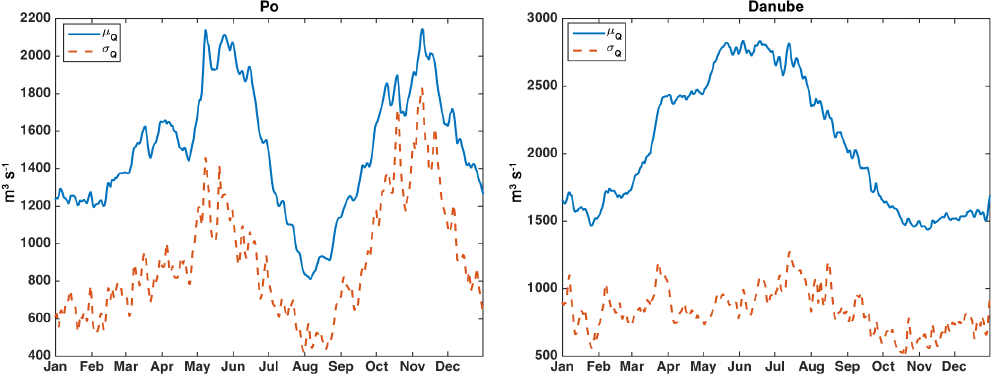
Figure 2. Daily mean value µ Q (m 3 s − 1 ) and daily standard deviation σ Q (m 3 s − 1 ) of the daily flows in the observation periods: 1920–2009 in the Po at Pontelagoscuro, 1901–2007 in the Danube at Bratislava. Table 1. Data description of observed time series. Descriptive statistics are given for non-deseasonalized data. Po